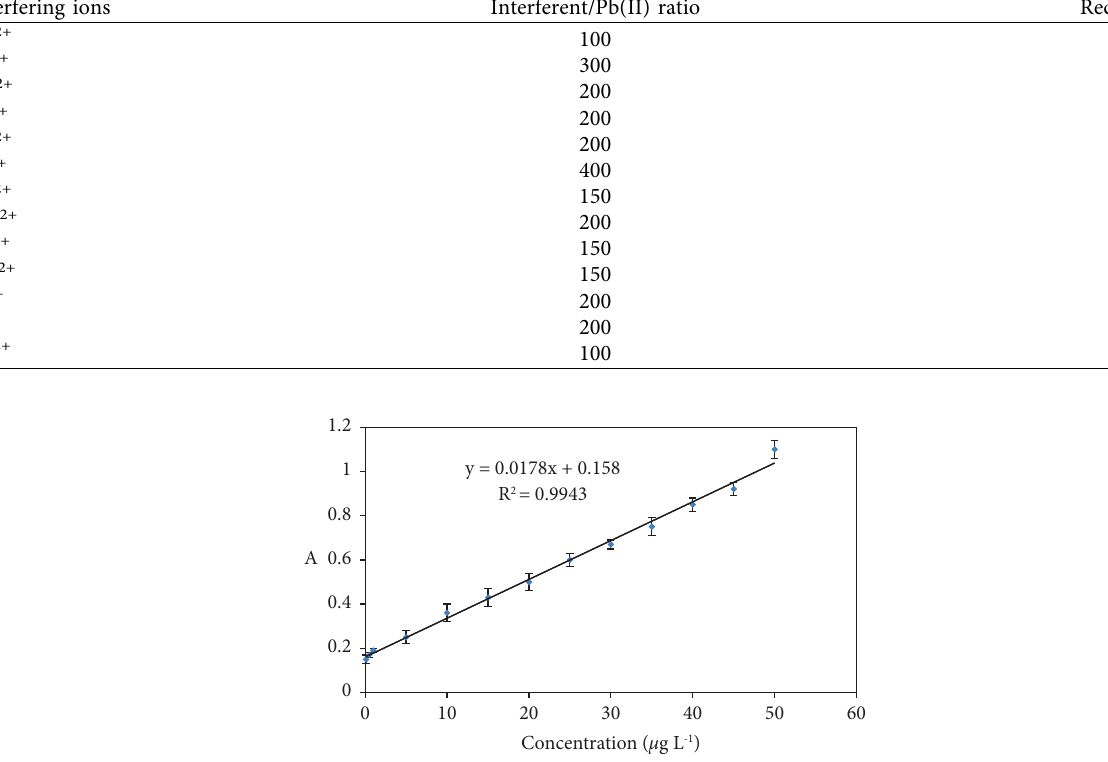
Figure 4: Calibration curve for Pb 2+ ion determination. Table 3: Comparison of the proposed method with some diferent methods for determination of lead.